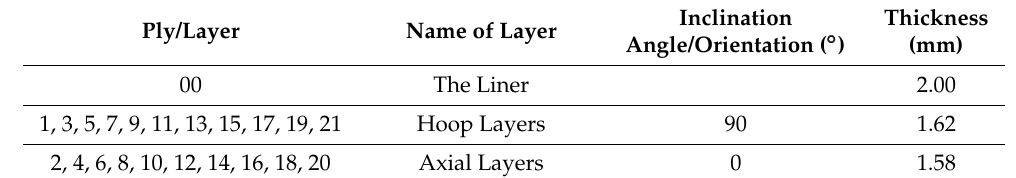
Table 6. Geometry and orientation of the [90/(0/90) 4 ] composite plies for conventional design.